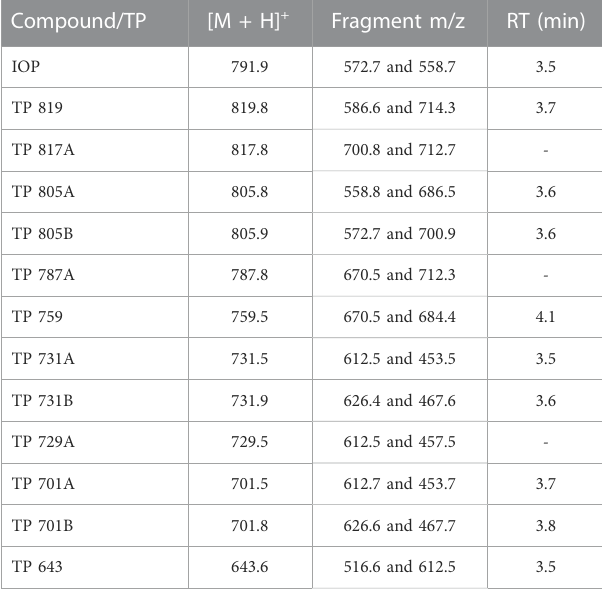
TABLE 2 Recorded transitions for iopromide (IOP) and its transformation products (TP) and retention times (RT) for ESI-MS/MS detection.